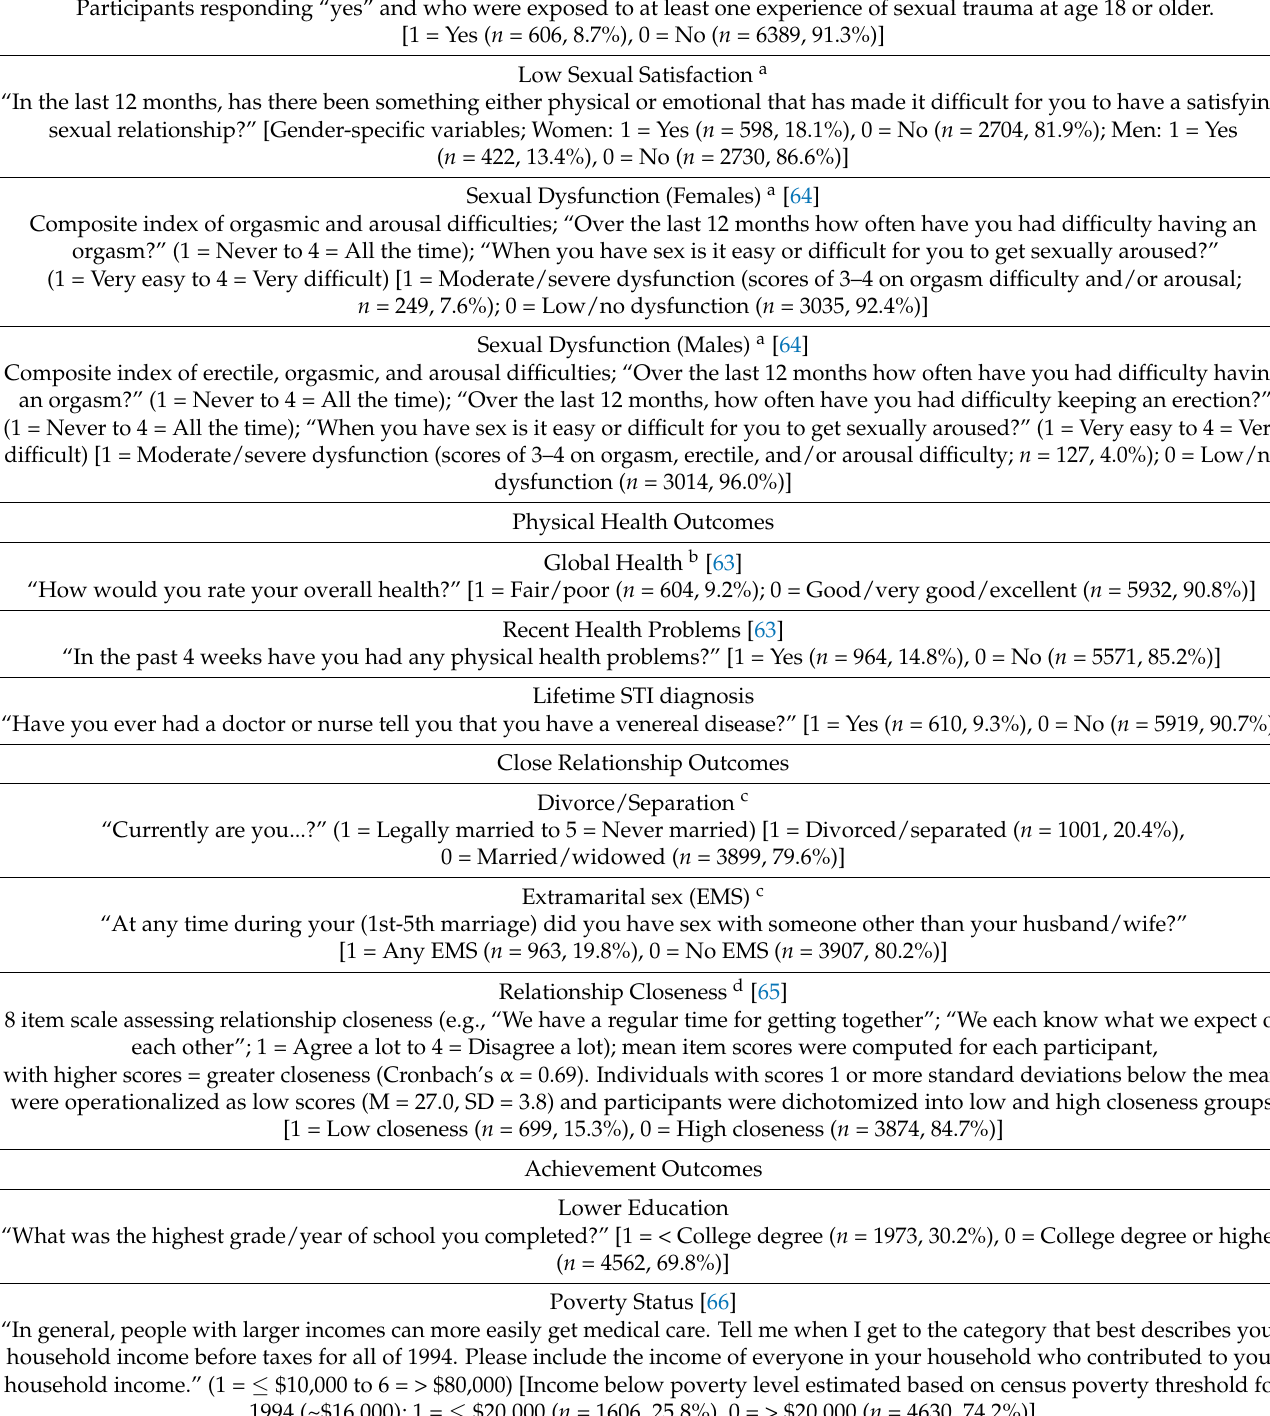
Table 1. Cont. Adult Adverse Outcomes (AAOs) Adult Sexual